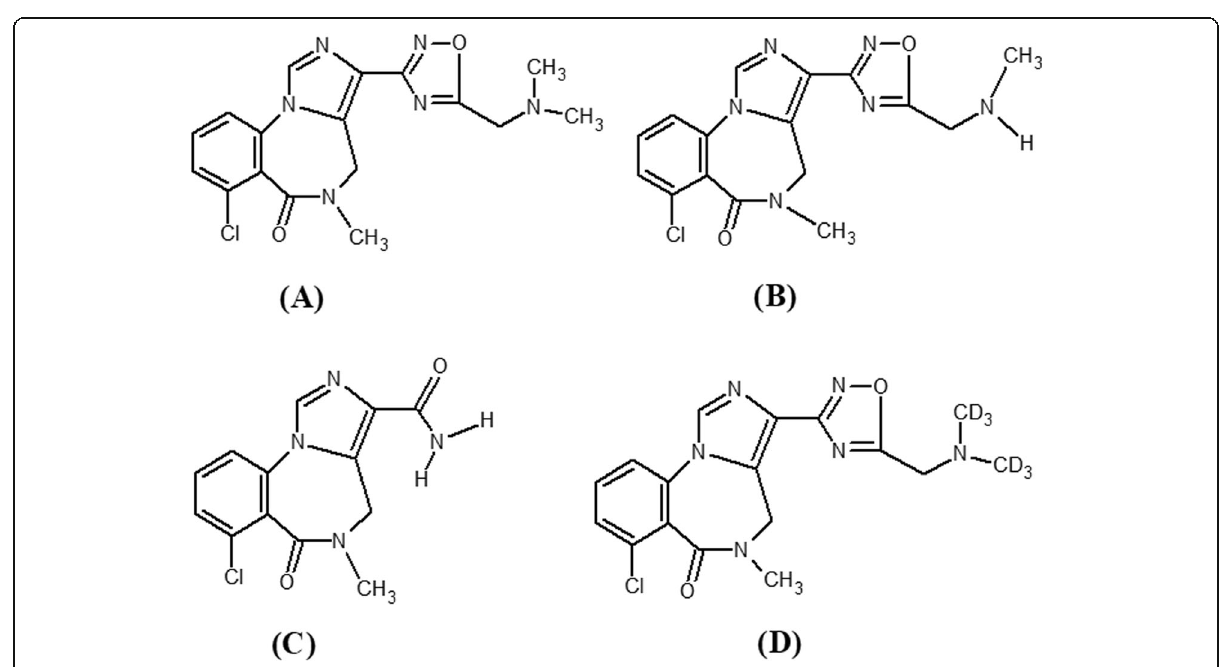
Fig. 1 Chemical structures of EVT201 ( a ), Ro46-1927 ( b ), Ro18-5528 ( c ), and the IS ( d